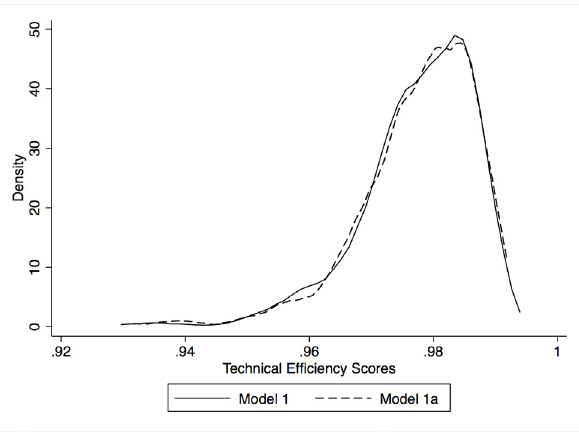
Figure 1. Distribution of Technical Efficiency